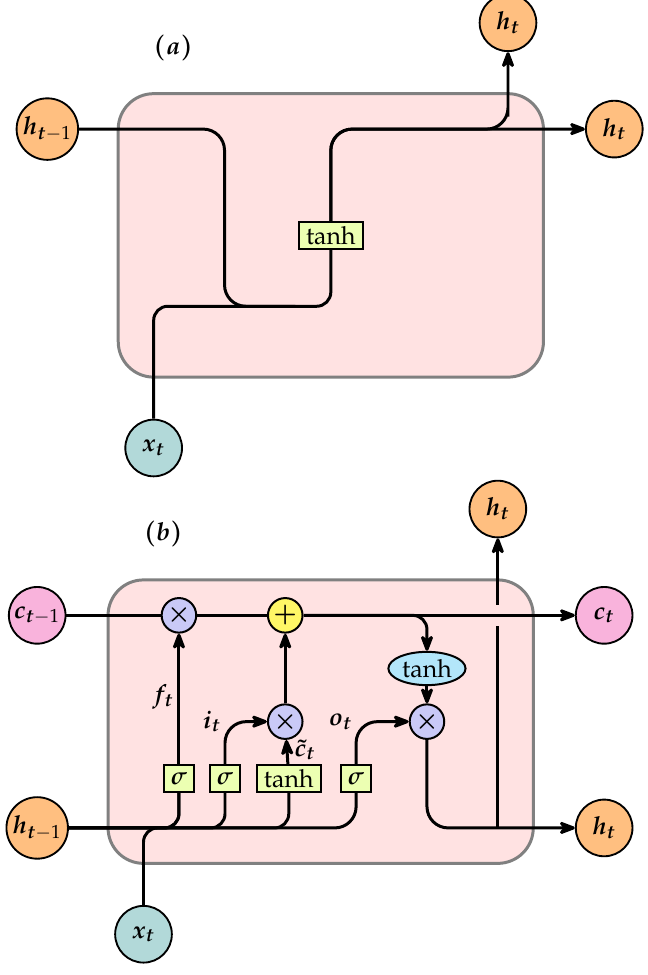
Figure 3. Diagram of structures of ( a ) RNN and ( b ) LSTM